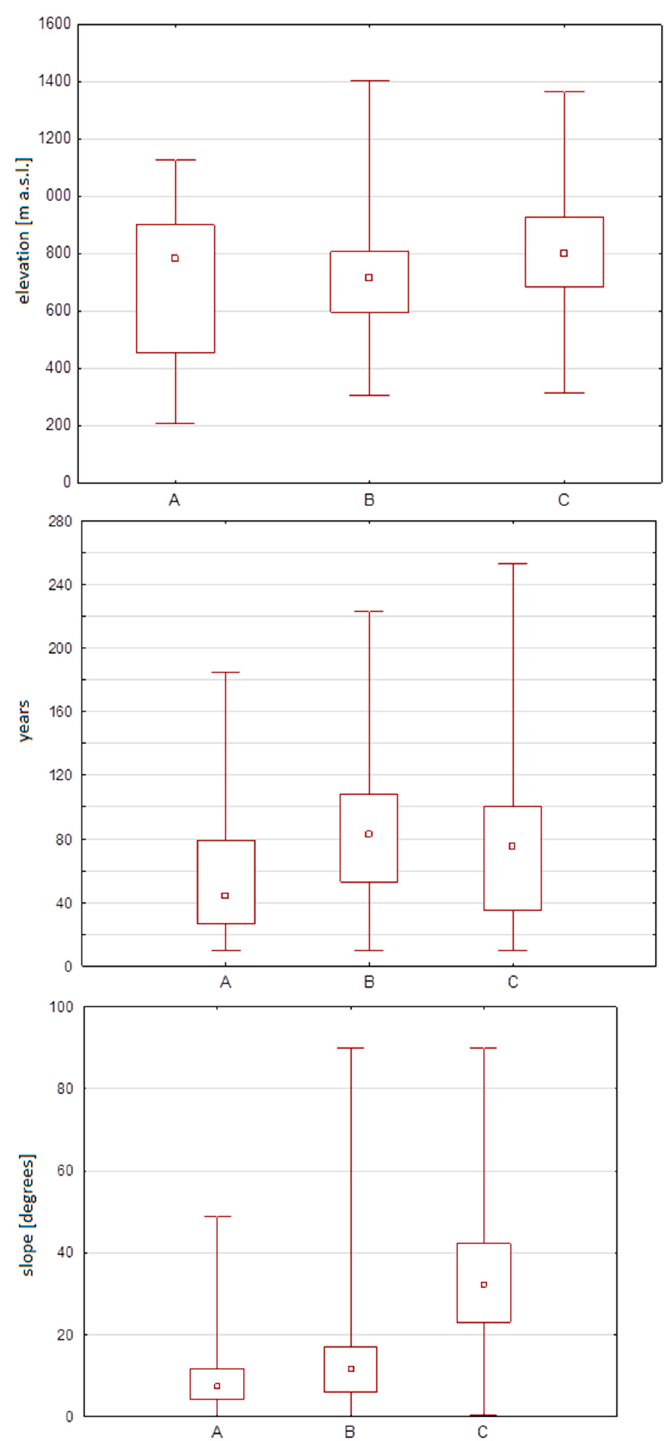
Figure 7. Box and whisker plot of elevation, age and slope for area A, B and C. The first and third quartiles de fi ne the box; the median is shown as “ □ ” and the whisker de fi nes the range of the data.